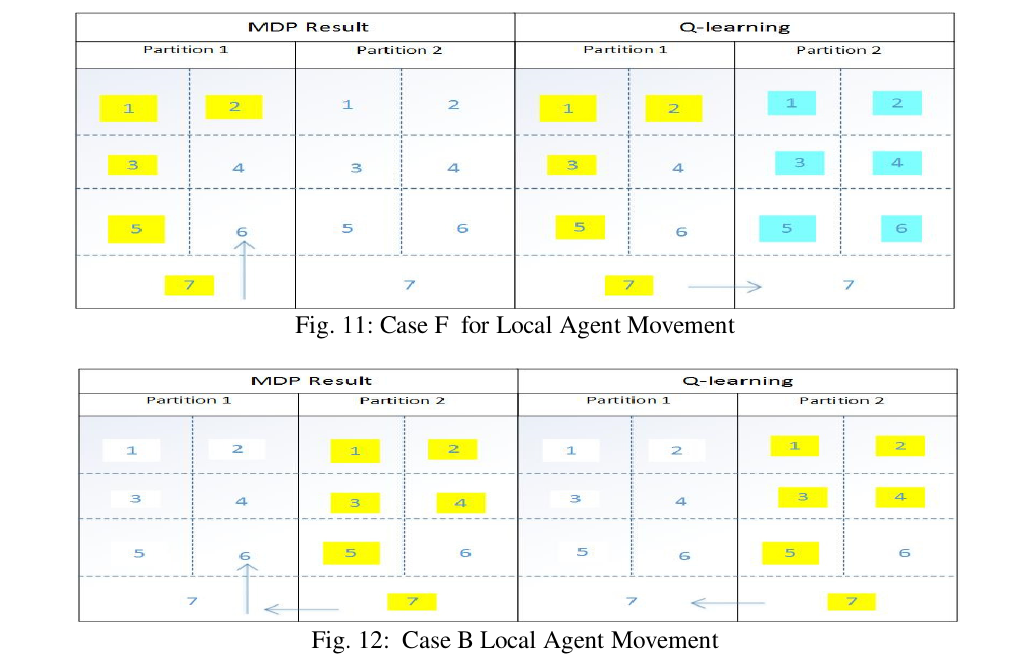
Fig. 11: Case A for Local Agent Movement